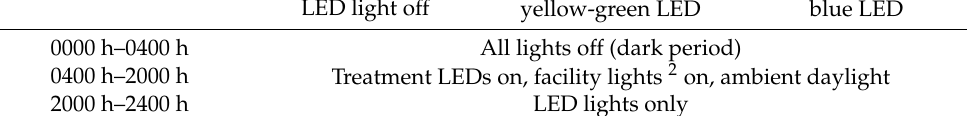
Table 2. Layout of the lighting schedule by time period and treatments across weeks. Week Time Period 1 2 3 White LED vs. White LED 1 vs. White LED 1 vs. LED light off yellow-green LED blue LED